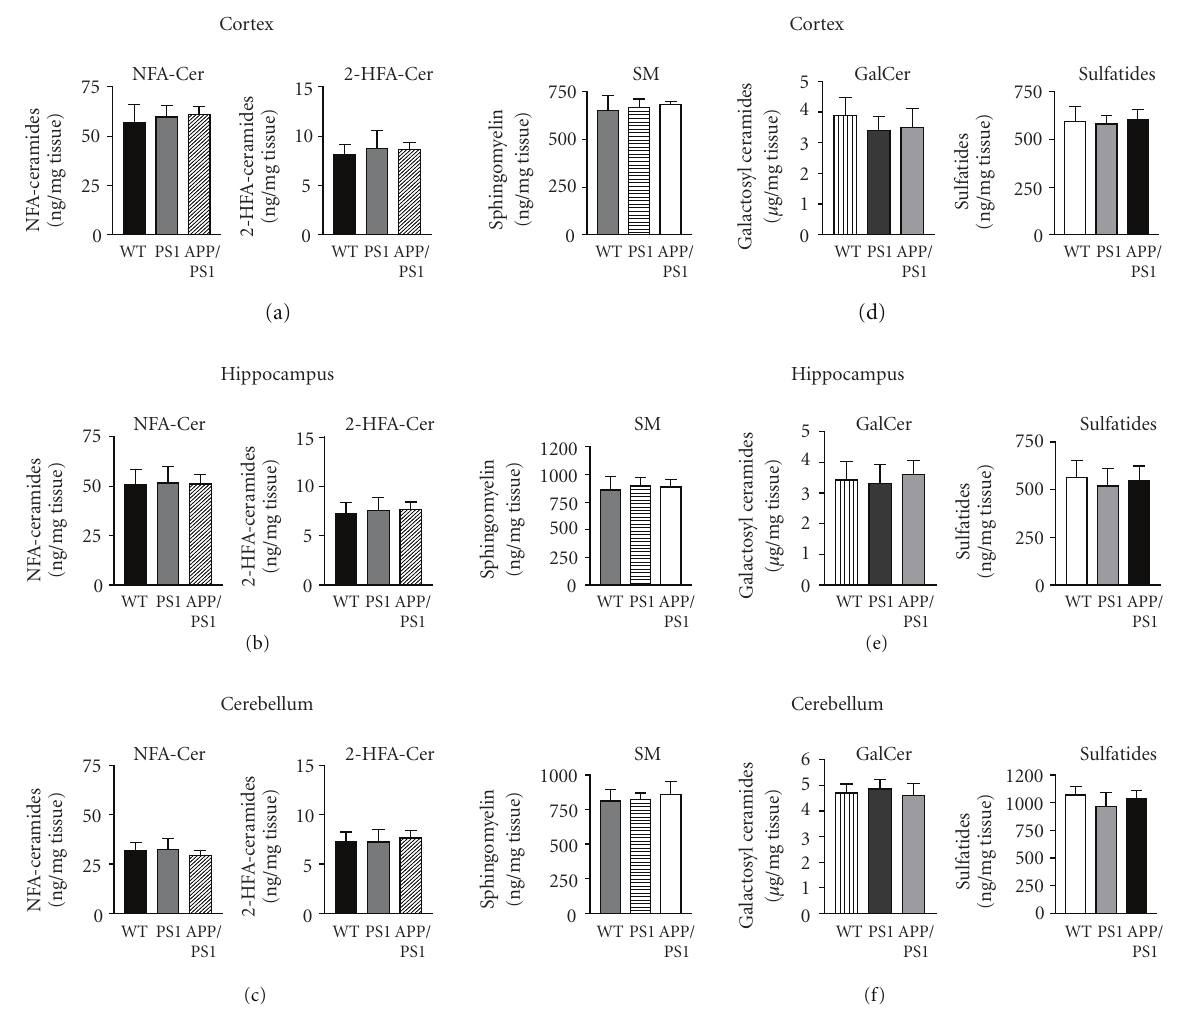
Figure 2: Levels of NFA-ceramides and 2-HFA-ceramides (a–c) and other related-sphingolipids (SM, GalCer, and sulfatides) (d–f) in the cortex, hippocampus, and cerebellum of 12-month-old APP SL /PS1 M146L , PS1 M146L mice, and age-matched nontransgenic mice. WT: wild- type control mice. Each sphingolipid class was analyzed by HPTLC and their respective concentrations were calculated from standard curves after densitometric scanning of the plates as described under Section 2. Values are expressed as the means ± S.D. There was no significant di ff erence in all sphingolipid levels between wild-type (WT), PS1 M146L , and APP SL /PS1 M146L mice in either cortex, hippocampus, or cerebellum (Dunn’s multiple comparison test following a Kruskall-Wallis test).